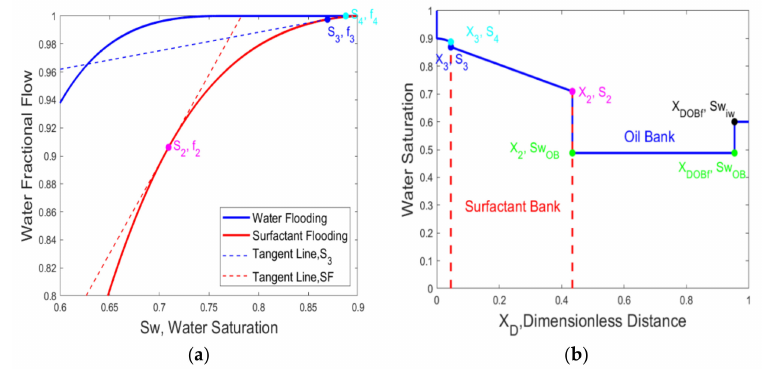
Figure 14. ( a ) Determination of the shock front during surfactant slug injection; and ( b ) water saturation profile and oil bank at t d , total = 0.34 PV, surfactant slug size t d , slug = 0.30